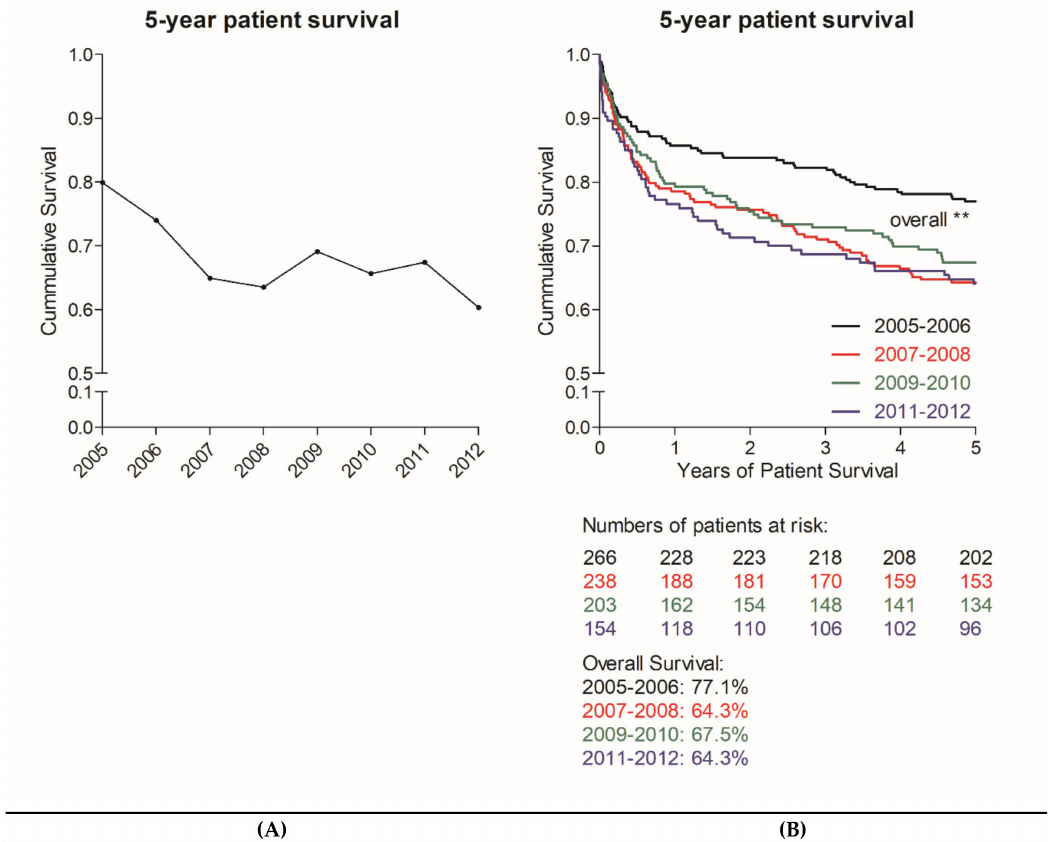
Figure 2. Long-term patient survival after the implementation of MELD-based liver allocation at our transplantation center. In the investigated period we found a significant reduction in long-term patient survival (5-year) after liver transplantation, from 79.9% in 2005 to only 60.3% in 2012 ( A ) (log-rank for all years p = 0.048). In comparison to the pre-MELD era (2005–2006) all periods after the implementation of MELD-based organ allocation showed inferior survival ( B ) (log-rank analysis: 2005–2006 vs. 2007–2012, p = 0.007; 2005–2006 vs. 2007–2008, p = 0.002; 2005–2006 vs. 2009–2010, p = 0.023; 2005–2006 vs. 2011–2012, p = 0.003). MELD, Model for End-Stage Liver